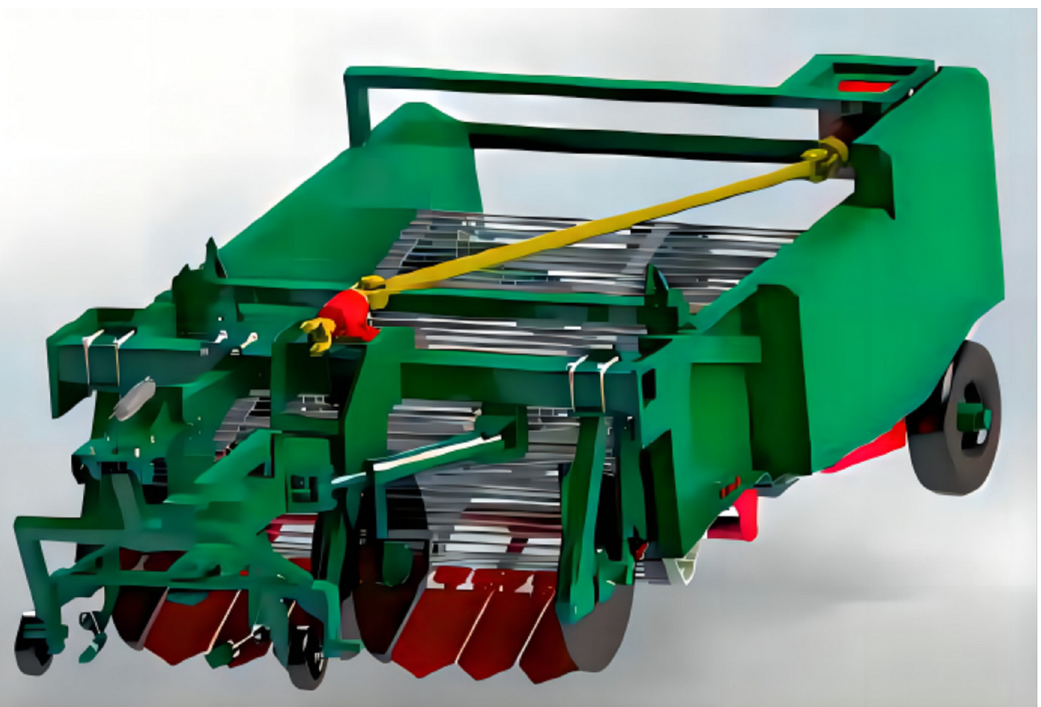
Figure 2. 4UGS2-type double-row sweet potato harvester.